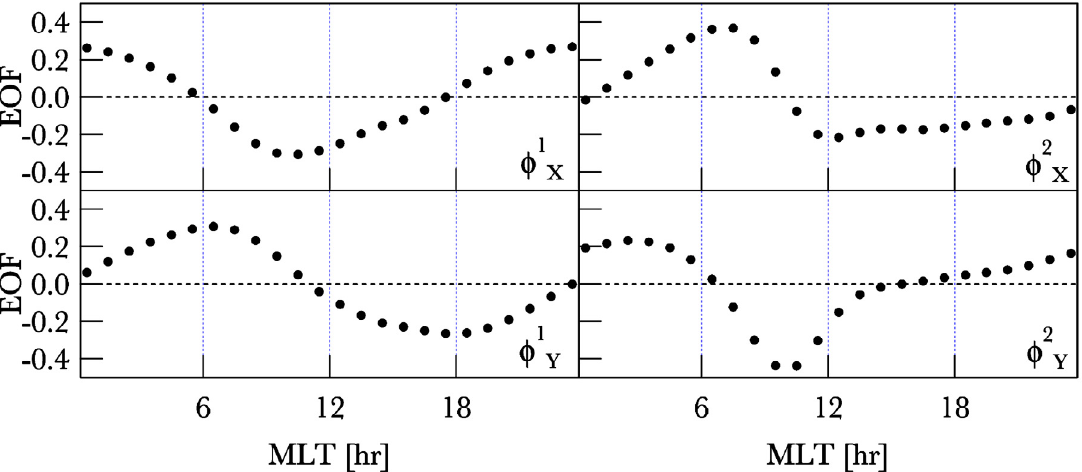
Figure 1. On the left: the first EOFs for X and Y magnetic field components. On the rigth: the second EOFs for X and Y magnetic field com- ponents. The results are relative to RES geomagnetic observatory.